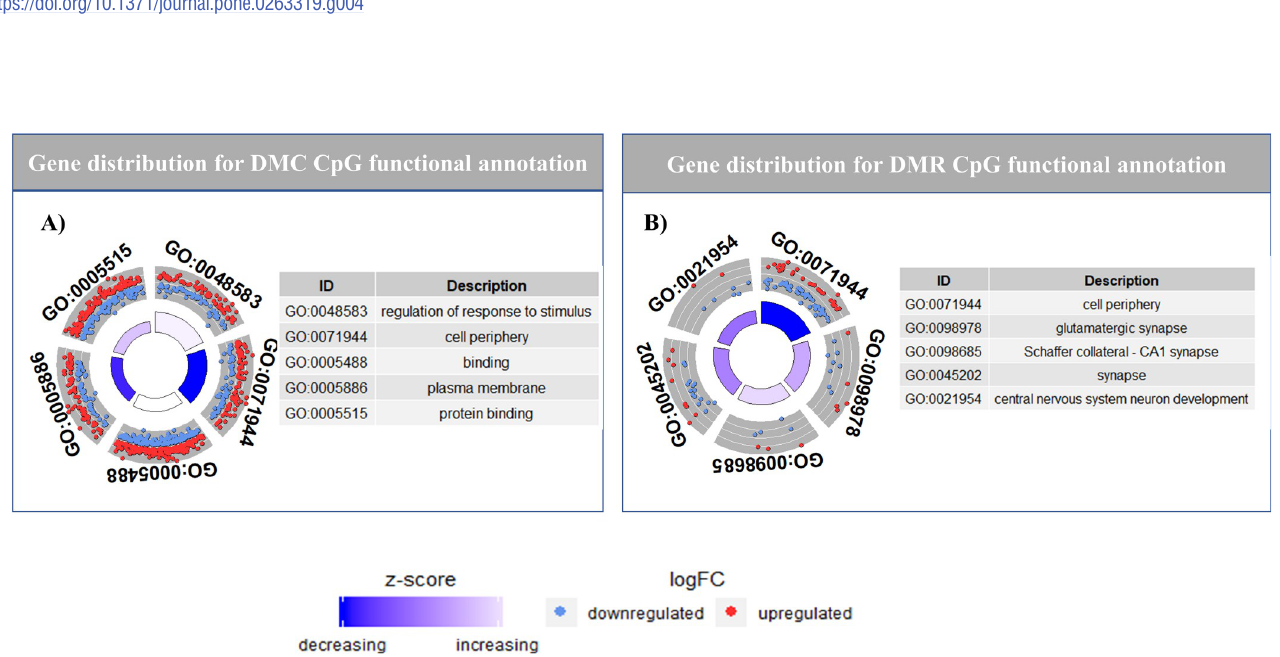
Fig 5. Functional annotation for DMC and DMR for CpG context. A) Representation of gene distribution across functional annotation terms for DMC CpG. The distribution of hypermethylated (red) and hypomethylated (blue) terms for each of the functional terms is represented in each quadrant. B) Representation of gene distribution across functional annotation terms for DMR CpG. The distribution of hypermethylated (red) and hypomethylated (blue) terms for each of the functional terms is represented in each quadrant. Enrichment of each term is reported as a z-score, where z-score is the ratio of difference between number of hyper methylated and hypomethylated DMC genes, and square root of total number of genes for that term.